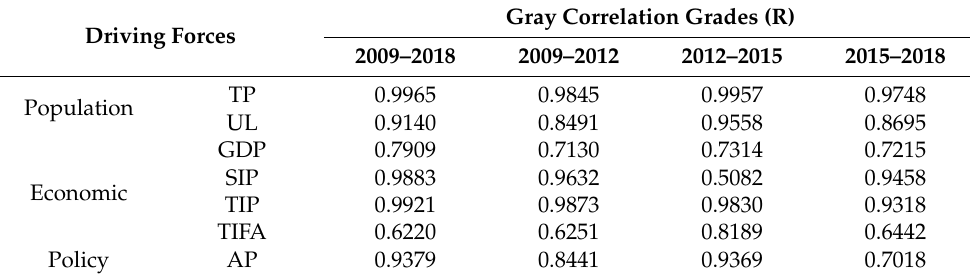
Table 7. Gray correlation grades of influential factors on ecosystem services value change. Gray Correlation Grades Driving Forces